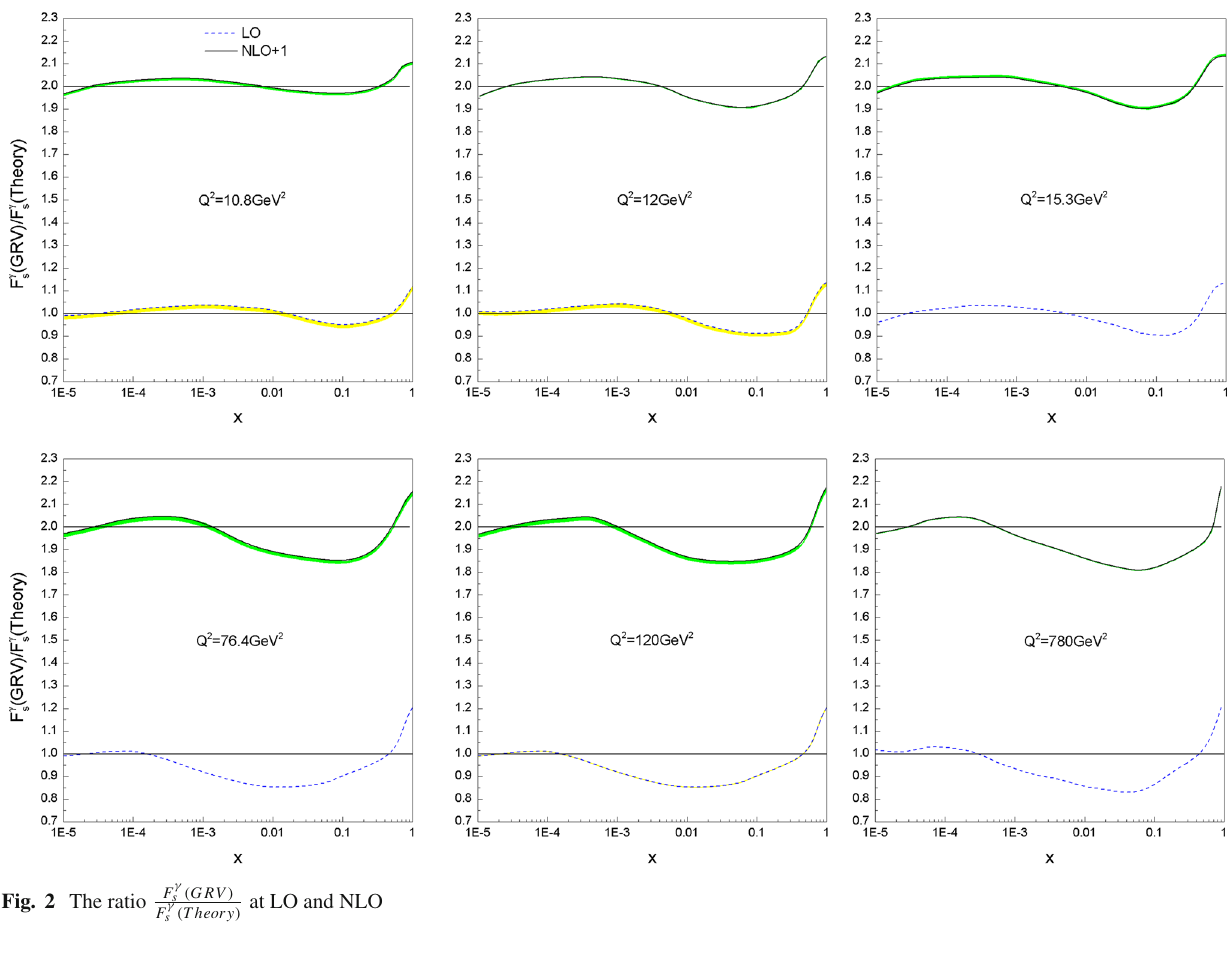
γ s ( GRV ) at LO and F γ s ( Theory )